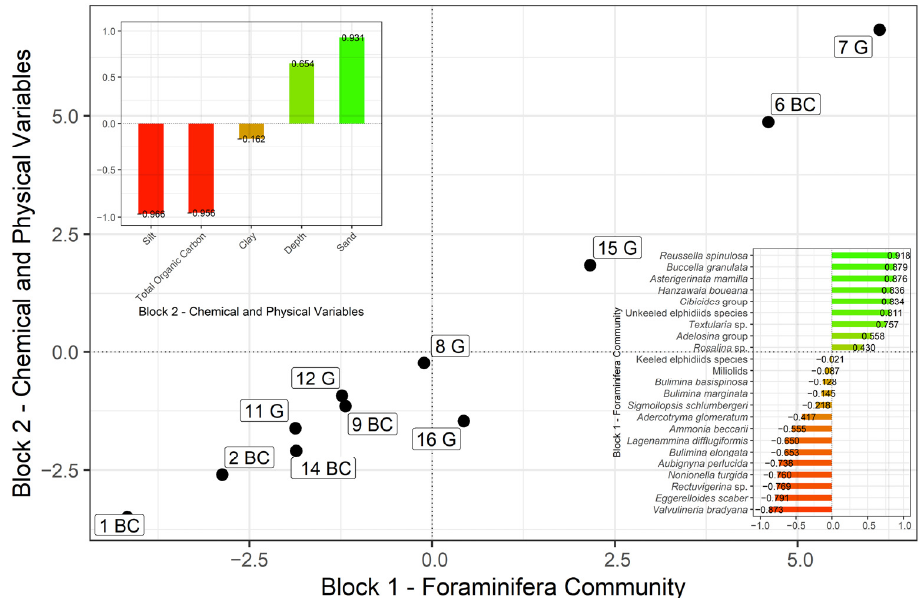
Figure 6. Scatterplot of the first axis of 2B-PLS between foraminiferal community (Block 1) and chemical and physical variables (Block 2); inserts show the correlation within and between blocks.